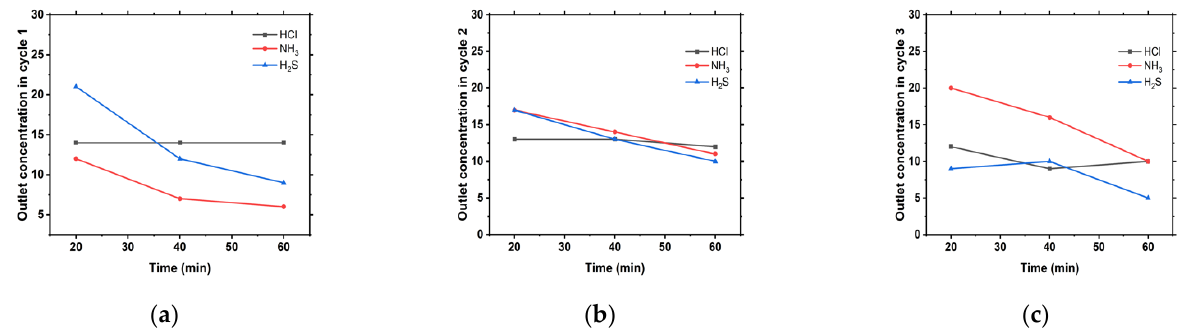
Figure 6. The outlet concentrations of contaminants in the calcination stage at carbonation temperature of 680 °C for the first ( a ), the second ( b ), and the third cycle ( c ).